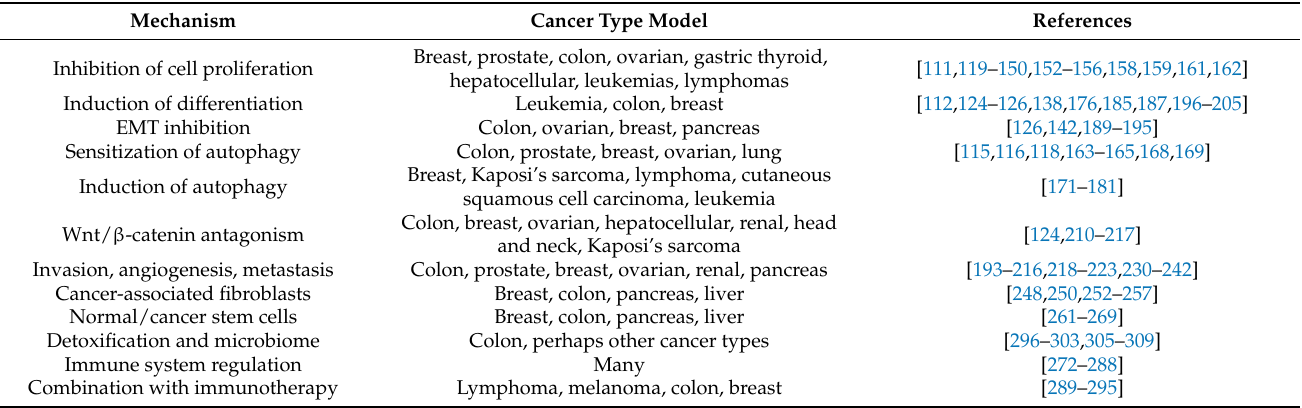
Table 11. vitamin D anticancer mechanisms in experimental model systems. List of key